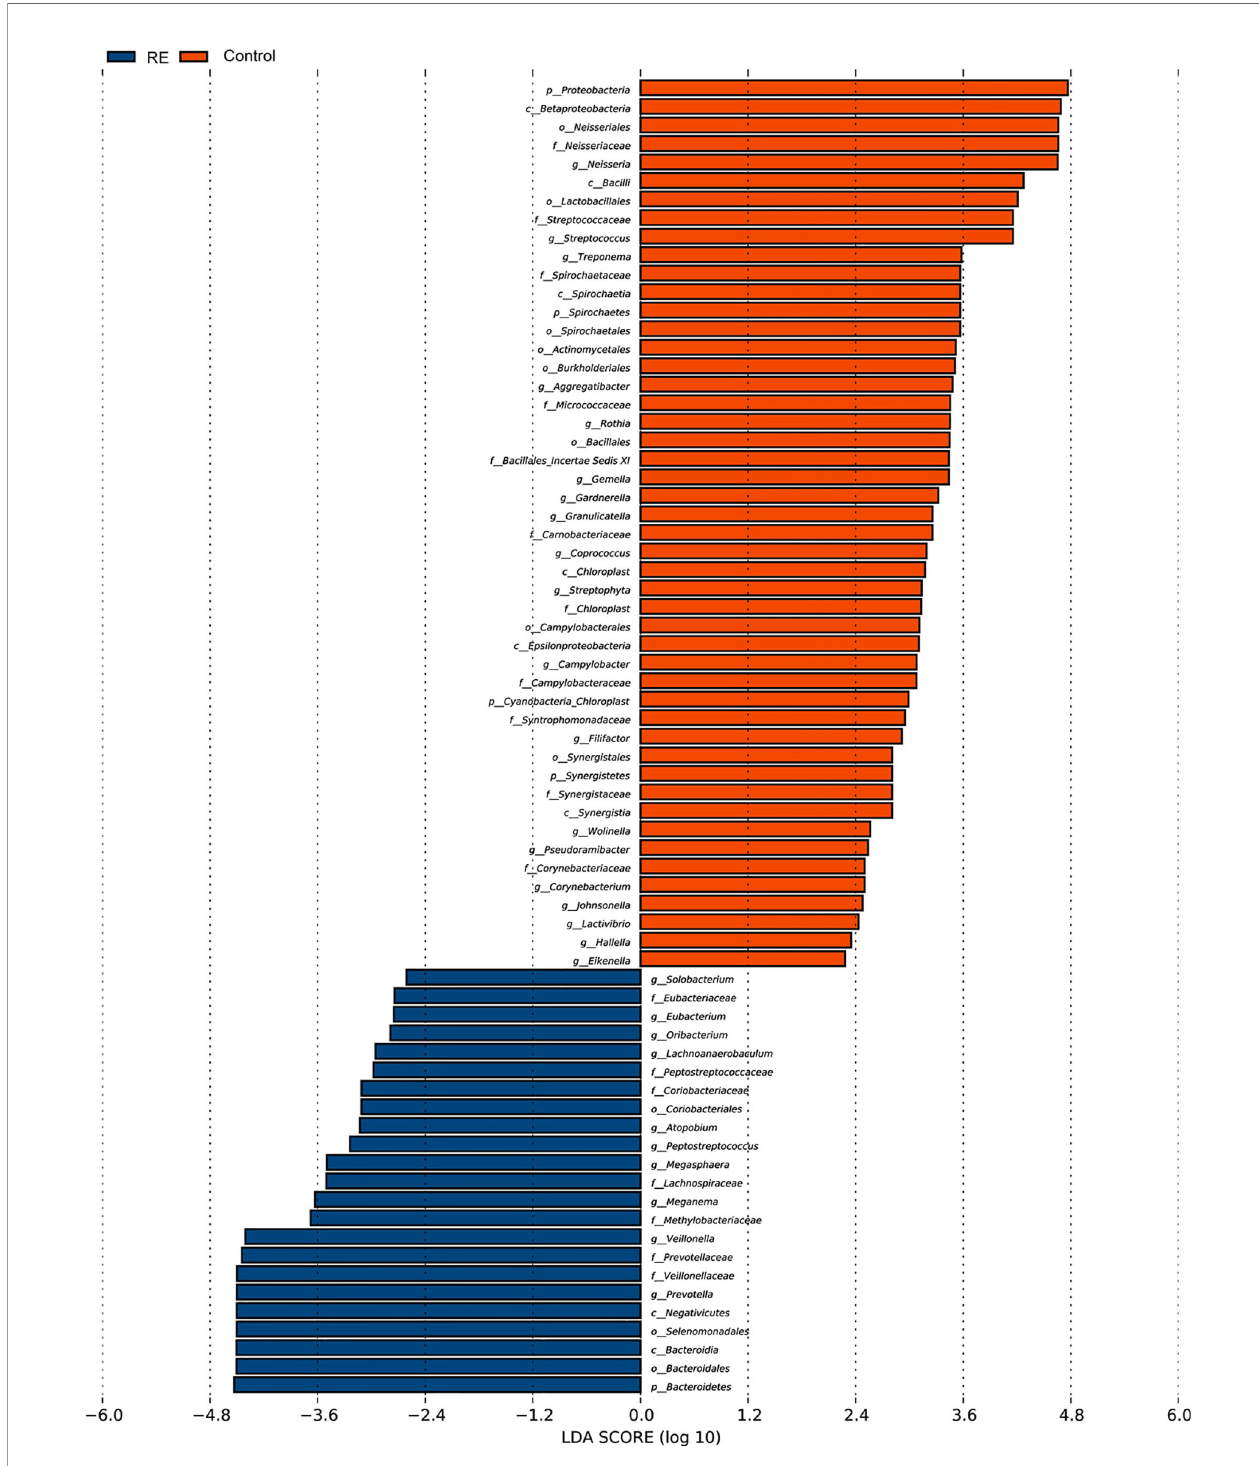
FIGURE 3 | Bacterial taxa diversities between Re fl ux Esophagitis (RE) and healthy controls. Bacterial taxa were detected by LEfSe ( p <0.05, linear discriminant analysis (LDA)>2 logs). Twenty-three texa were discovered to be enriched in patients with RE ( blue bars ) compared with controls, and 48 texa were discovered to be enriched in Controls ( red bars ) compared with patients with re fl ux